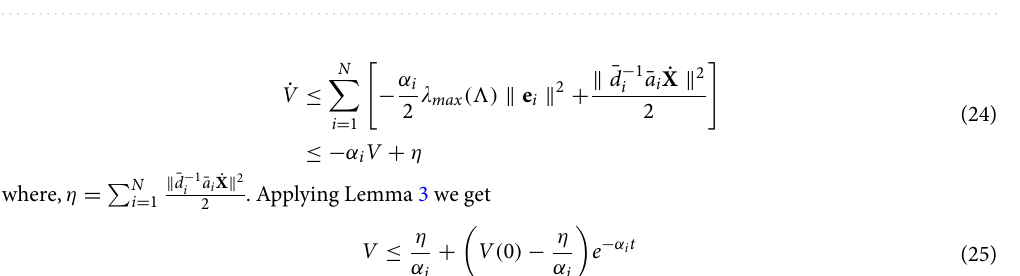
Figure 2. Philosophy of neuro-adaptive